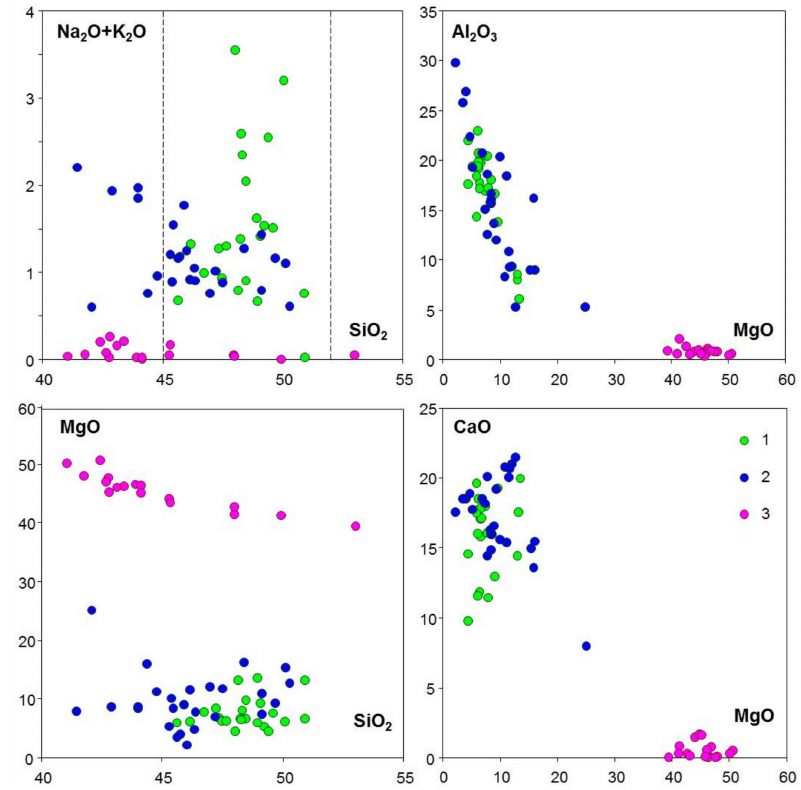
Figure 12. Ophiolitic gabbro and peridotites in major-element variation diagrams. 1, 2 = gabbro of 1 and 2 types (see Table S5 in Supplementary Materials); 3 = dunite and